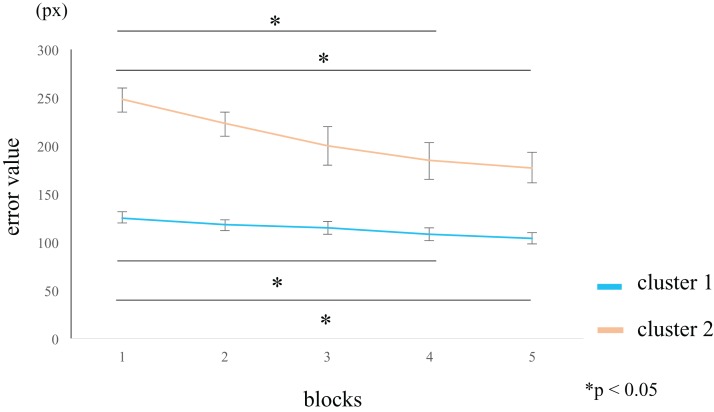
Block-wise transition of error values.Participants in cluster 1 (blue line) show low error values in block 1, and small difference in the error values among blocks. Participants in cluster 2 (orange line) show high error values in block 1 that decrease over the course of the task. A within-group comparison between clusters 1 and 2 showed a significant error reduction in blocks 4 and 5 than in block 1. However, the effect sizes for blocks 4 and 5 were larger in cluster 2 than in cluster 1 (see Table S2). The data represent the means ± standard error. px, pixel.